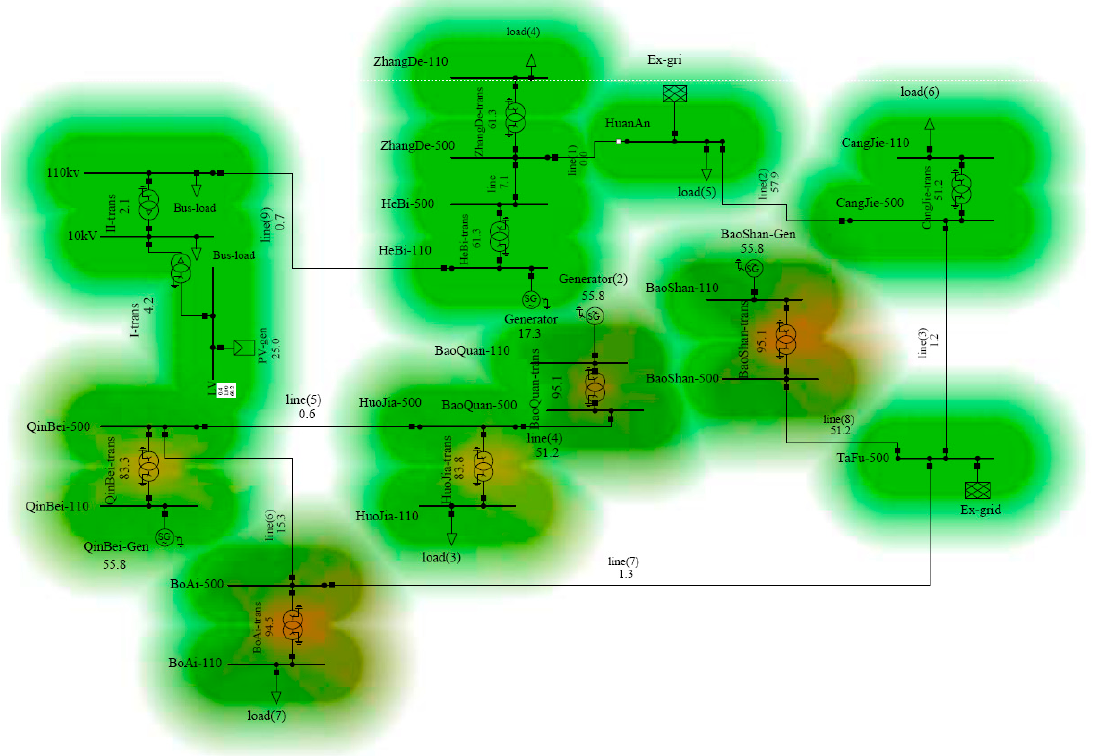
Figure 5. Yubei PV power generation grid-connected tide calculation cloud map.